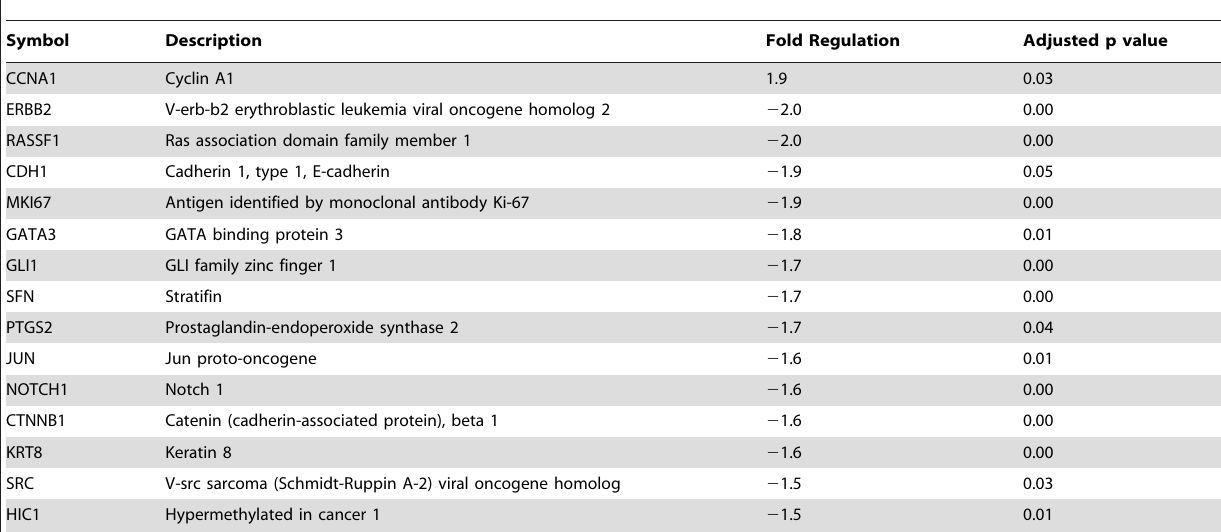
Table 5. Gene differentially expressed between the Her2- and Her2 + patients.